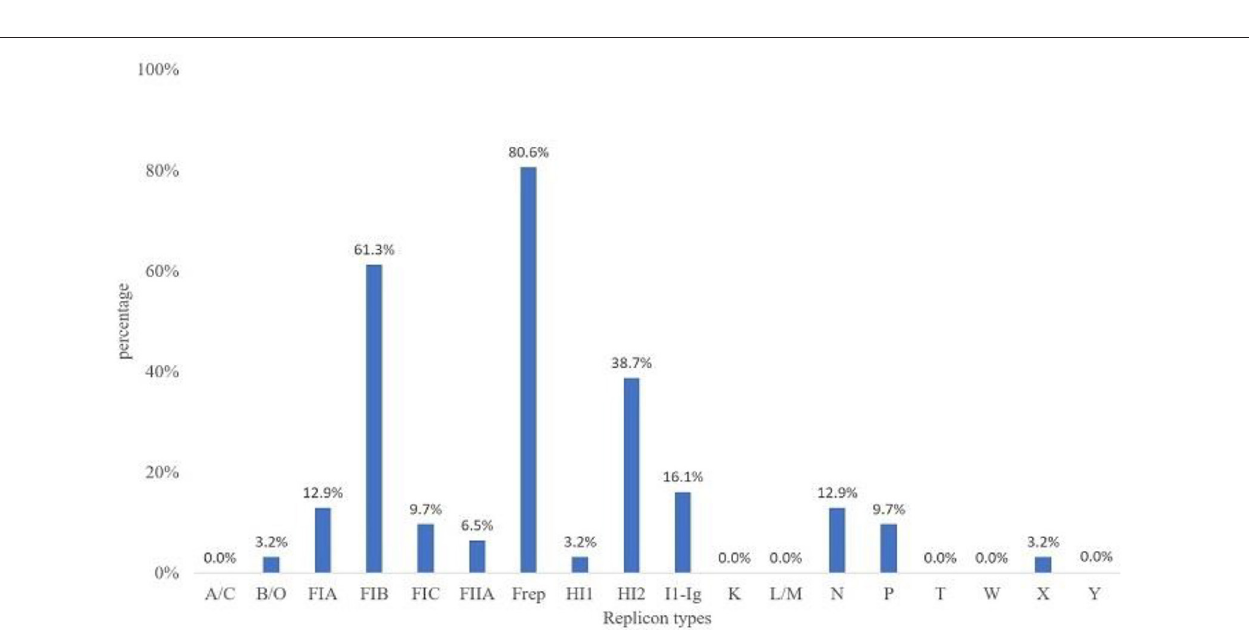
Frontiers in Veterinary Science |